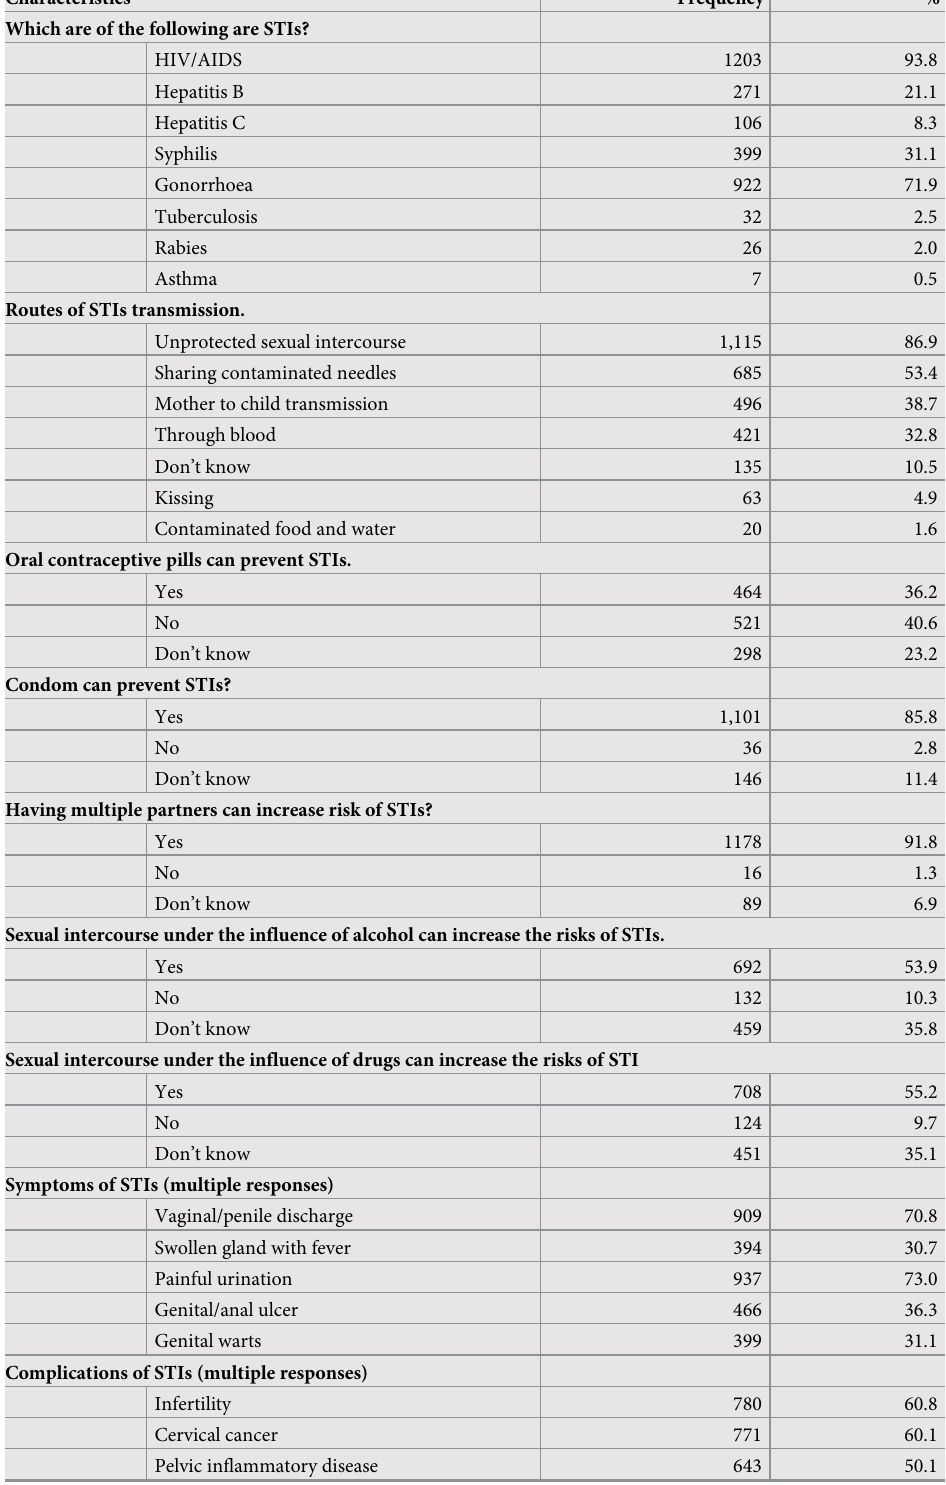
Table 3. Knowledge of STI among the university students of